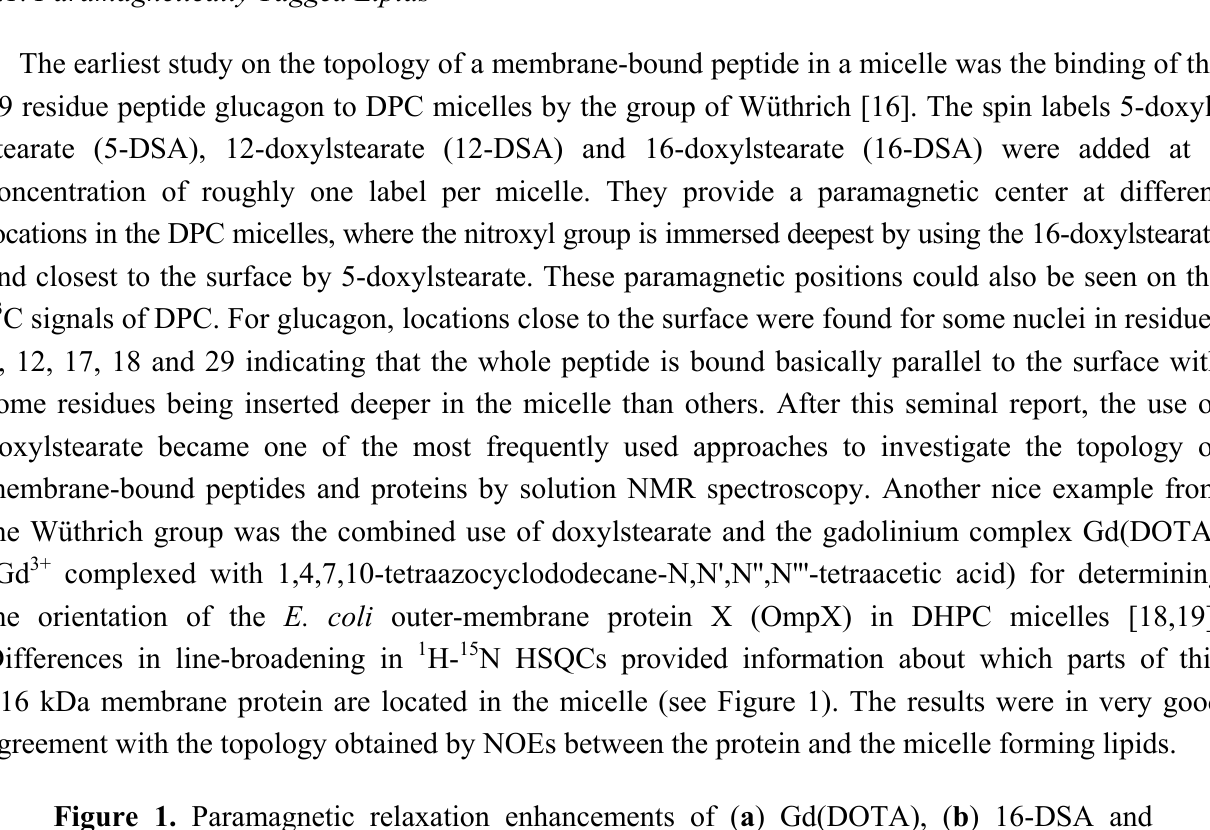
Figure 1. Paramagnetic relaxation enhancements of ( a ) Gd(DOTA), ( b ) 16-DSA and ( c ) 5-DSA on the membrane-bound protein OmpX. The darkness of the color indicates the size of the PREs with dark purple corresponding to highest PREs. Reproduced with permission from